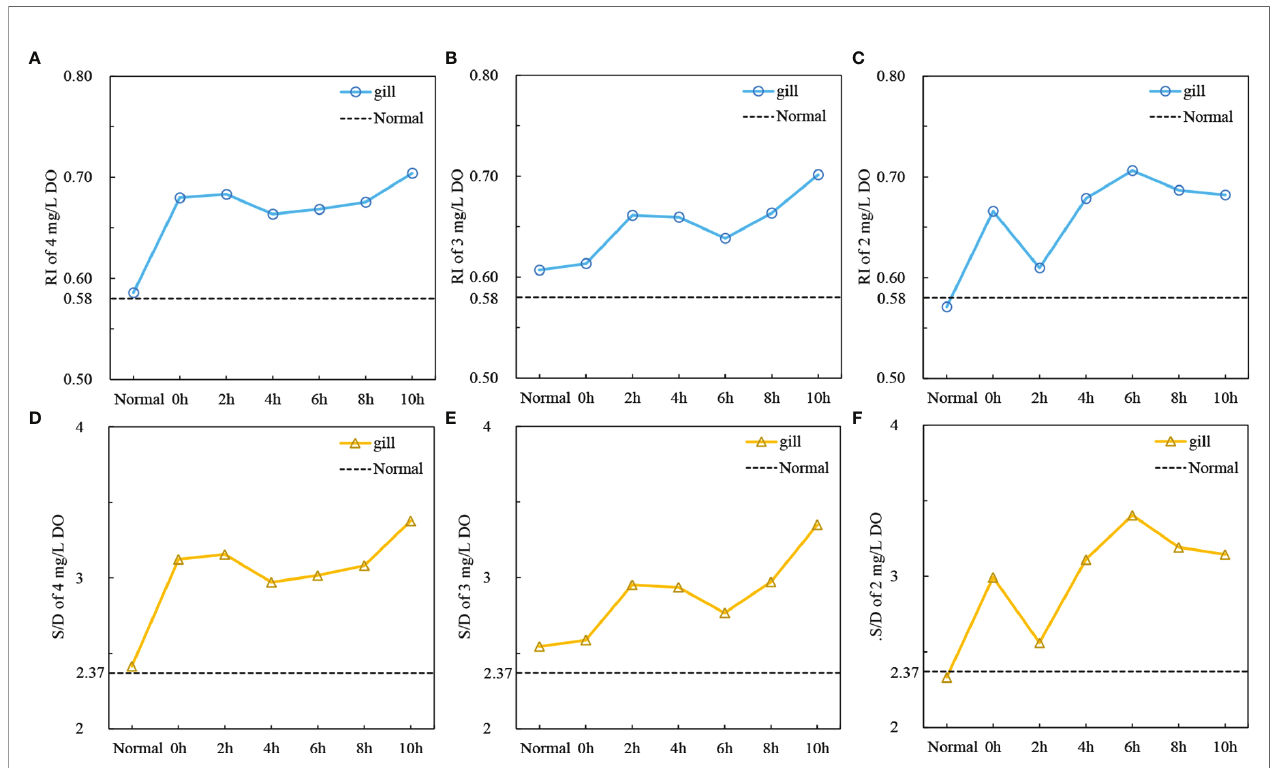
FIGURE 5 | The changes resistance index (RI) and S/D ratio of gill, mantle and adductor muscle under three hypoxia stress degrees [ (A) RI, 4mg/L DO; (B) RI, 3mg/L DO; (C) RI, 2mg/L DO; (D) S/D, 4mg/L DO; (E) RI, 3mg/L DO; (F) RI, 2mg/L DO; Normal: RI and S/D values under 6.5 mg/L DO level; means, n =